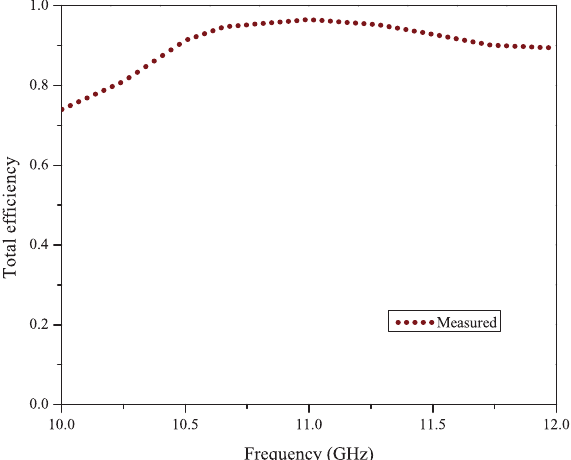
Figure 14. Efficiency of the proposed hybrid waveguide-SSPP